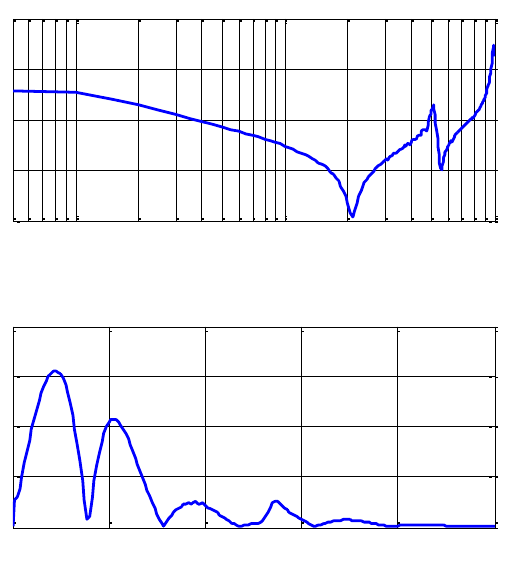
Figure 11: Spectrums of the input impedance Z in and current I in